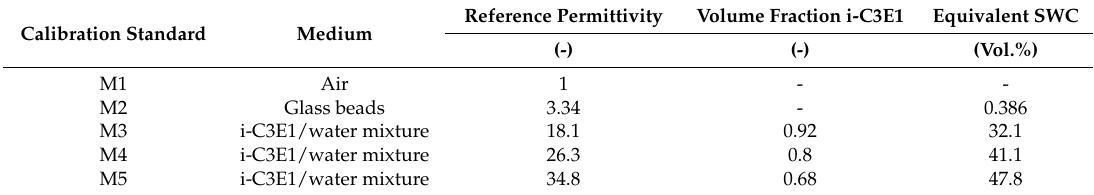
Table 1. The reference permittivity of the calibration media as well as the equivalent soil water content (SWC) calculated with the Topp equation